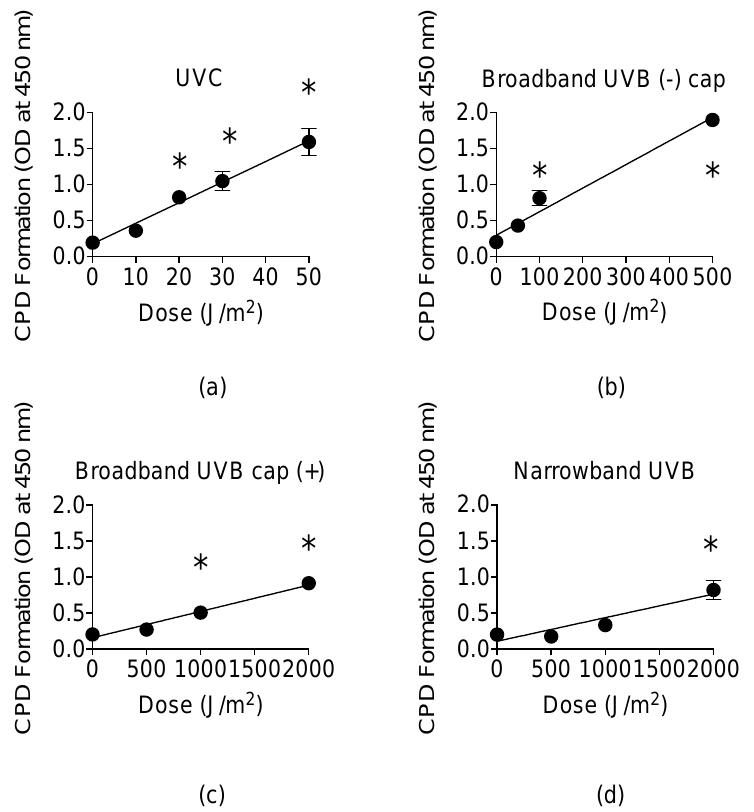
Figure 5. UV light formation of cyclobutane pyrimidine dimers (CPDs) in CHO10B2 cells at noncytotoxic and cytotoxic dosages. ( a ) UVC-exposed cells; ( b ) Broadband-UVB-exposed cells without petri dish cap off during exposure; ( c ) Broadband-UVB-exposed cells with petri dish cap on during exposure; ( d ) Narrowband-UVB-exposed cells. Error bars indicate standard error of the mean of at least three independent experiments. * Indicates statistically significant differences compared to control ( p < 0.05), one-way ANOVA followed by Turkey’s Multiple Comparison Test.